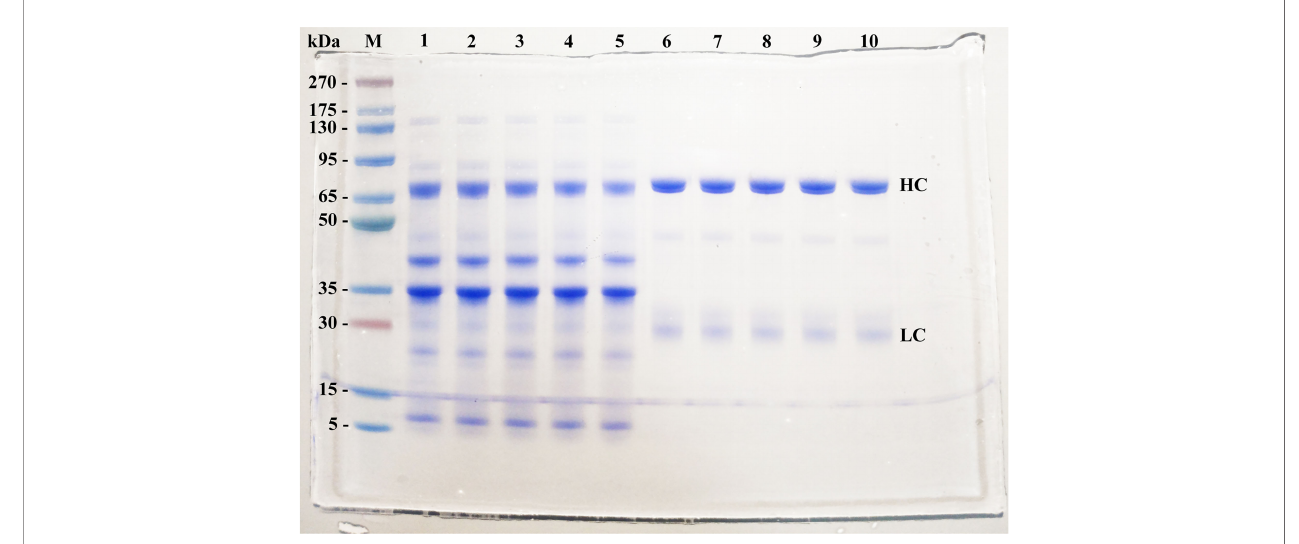
FIGURE 1 | SDS-PAGE patterns of IgY-R at the 2 stages of puri fi cation (4 µg per line). M stands for molecular weight marker, with size indicated on the left; Lanes 1-4: WSF of yolks belonging to hens immunized with 5, 12.5, 25, and 50 µg of rRBD; lane 5: WSF of control yolks; lanes 6-9: puri fi ed IgY of yolks belonging to hens immunized with 5, 12.5, 25, and 50 µg of rRBD; lane 10: puri fi ed control IgY. HC, Heavy chain; LC, Light